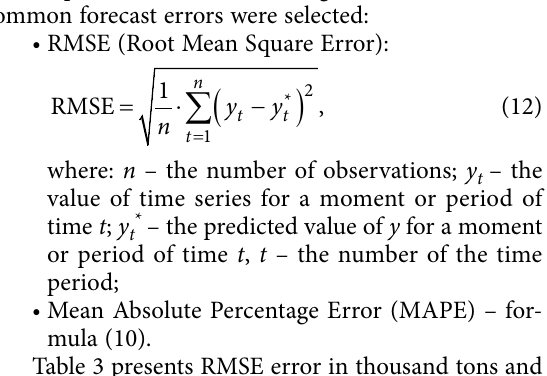
Table 1. The coefficients of harmonic analysis obtained using artificial immune algorithms